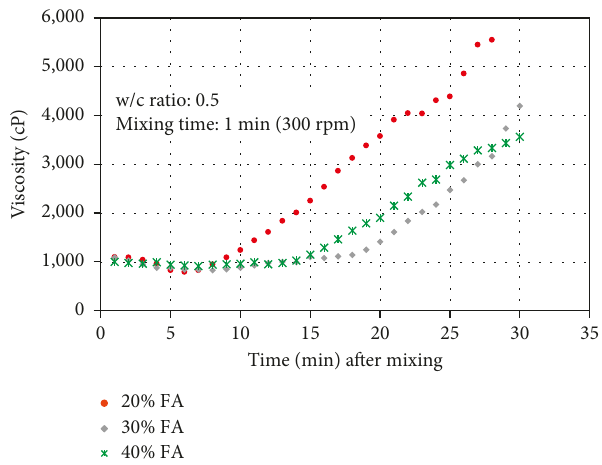
Figure 9: Viscosity with fly ash content (0.5w/c